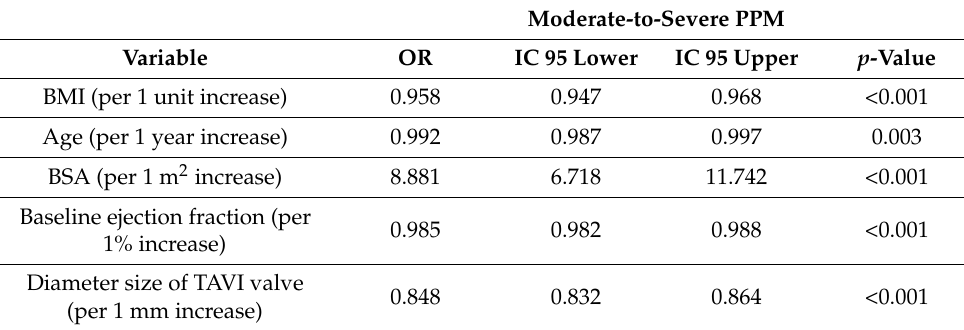
Table 3. Multivariate adjustment of predictors of PPM.